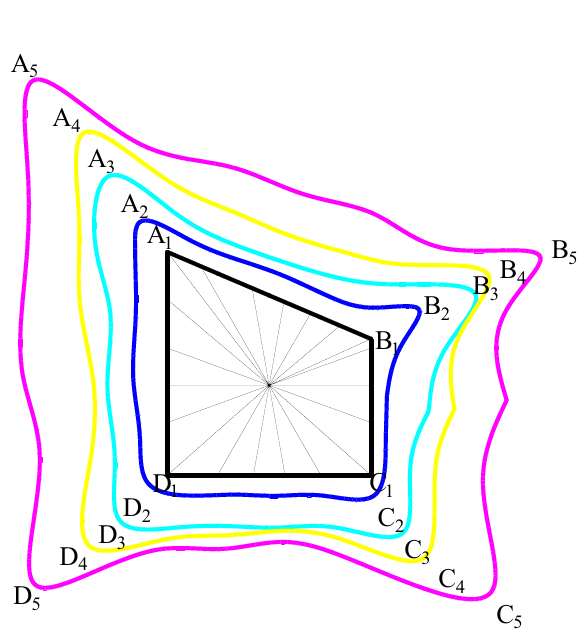
Figure 15. Stress distribution of roadway cyclic deformation